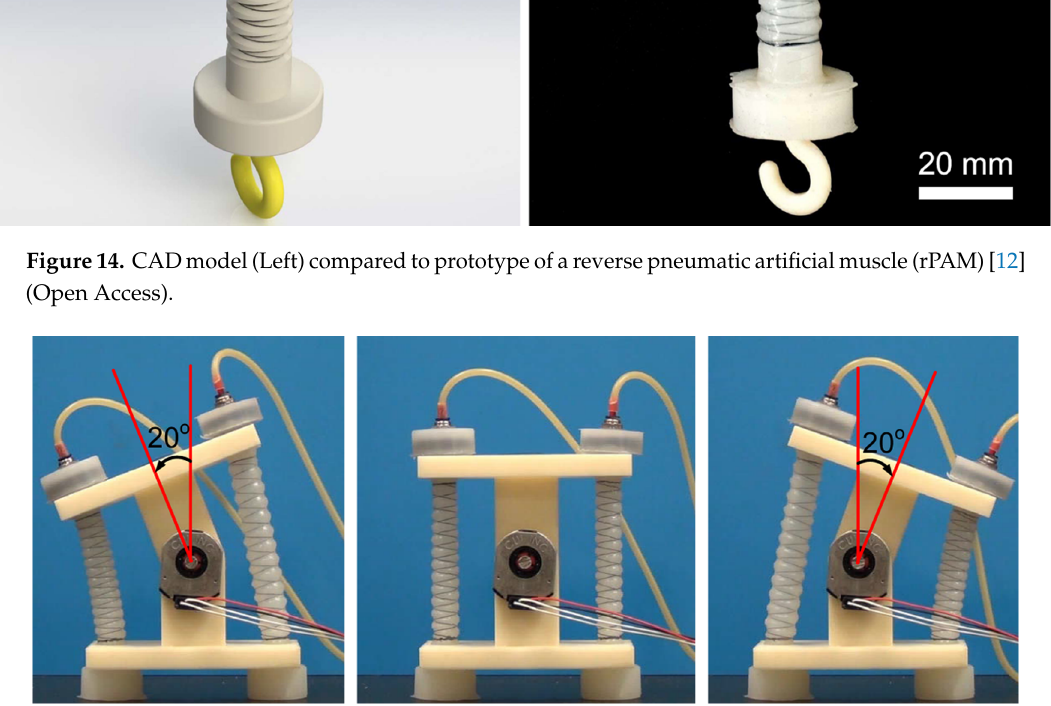
Figure 15. Experimental set-up of a reverse pneumatic artificial muscle (rPAM) [12] (Open Access).